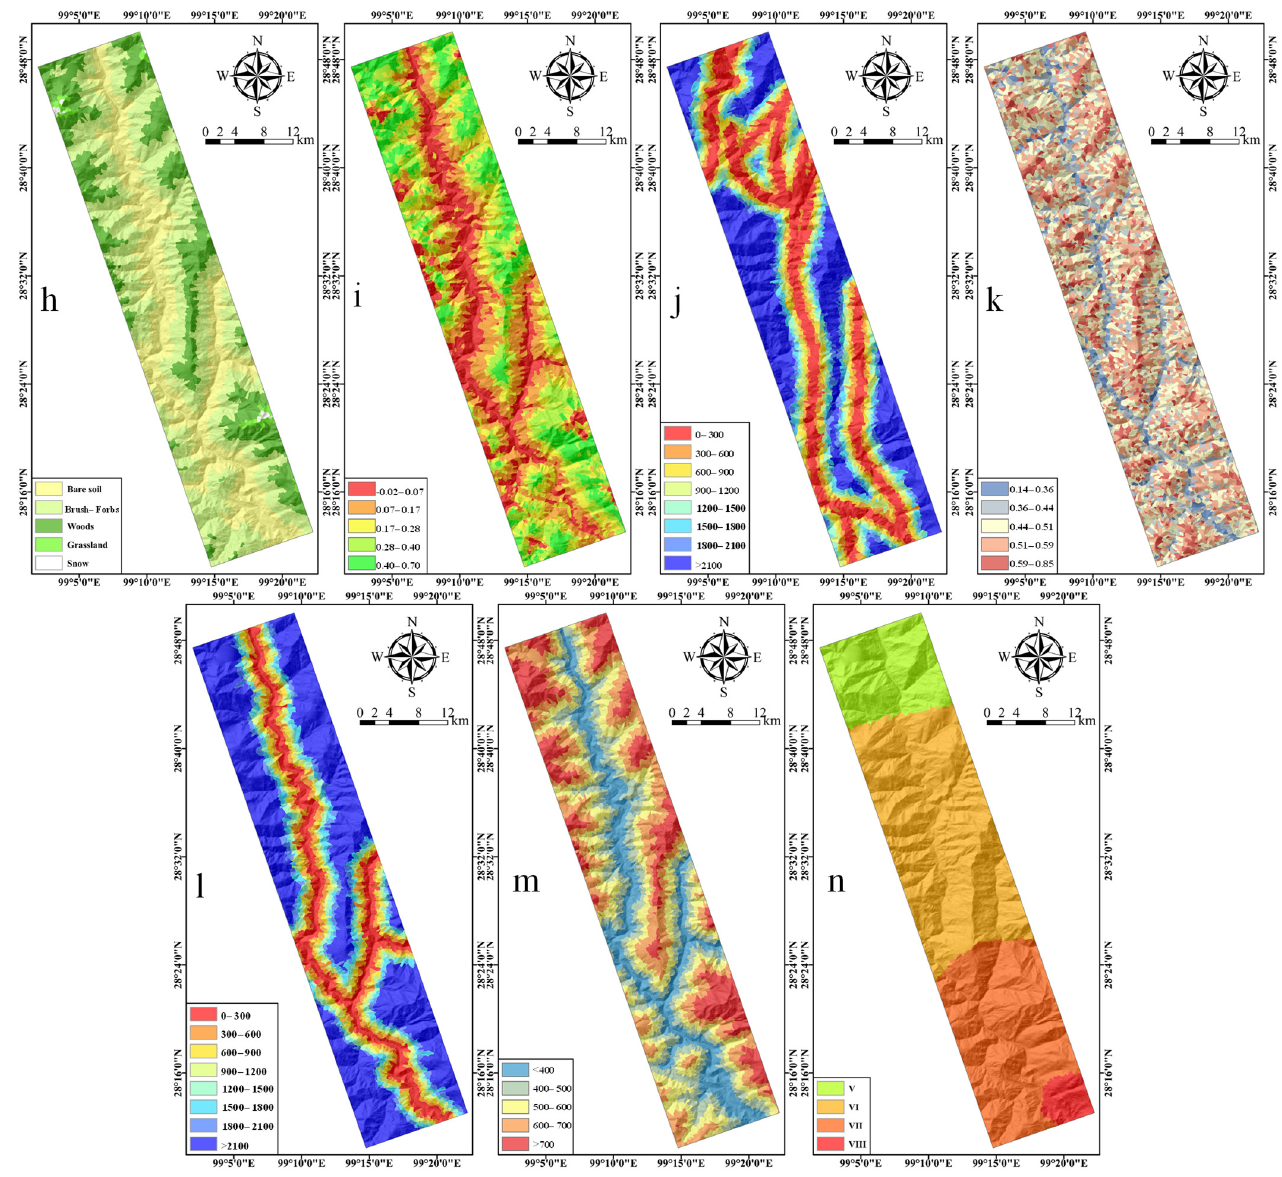
Figure 8. Landslide conditioning factor maps: ( a ) lithology; ( b ) rock hardness; ( c ) elevation; ( d ) slope angle; ( e ) slope aspect; ( f ) topographic relief; ( g ) curvature; ( h ) land use; ( i ) normalized difference vegetation index (NDVI); ( j ) distance from faults; ( k ) Strahler’s integral value; ( l ) distance from rivers; ( m ) rainfall; and ( n ) earthquake intensity.